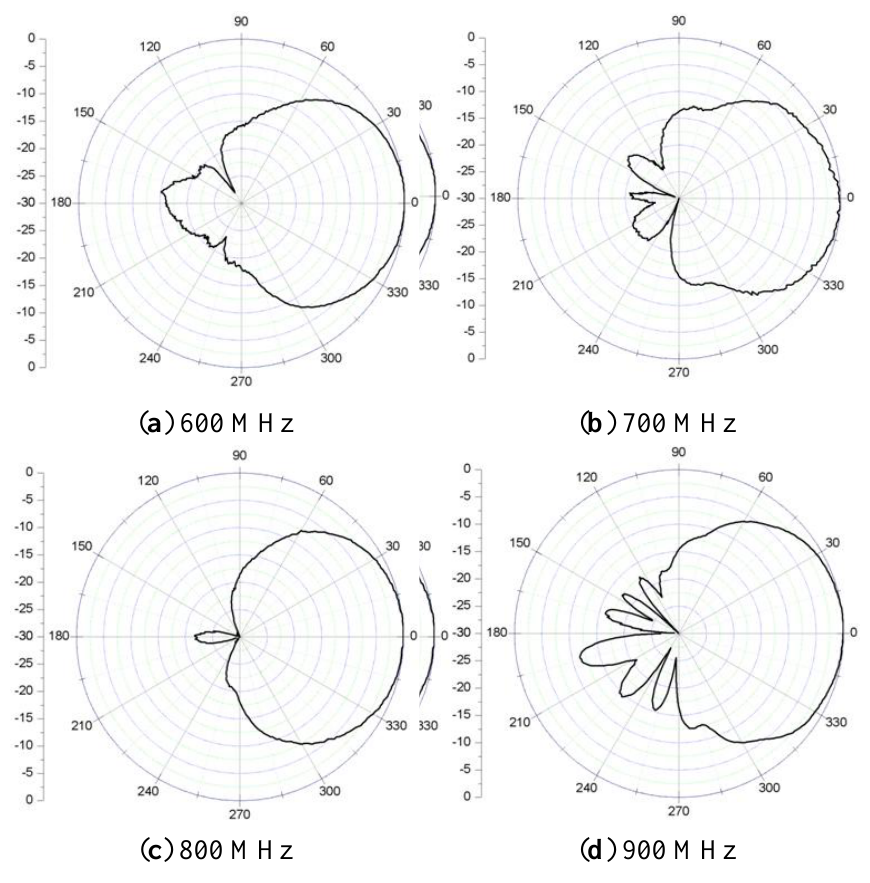
Figure 6. Measured E-plane radiation pattern of micro-strip